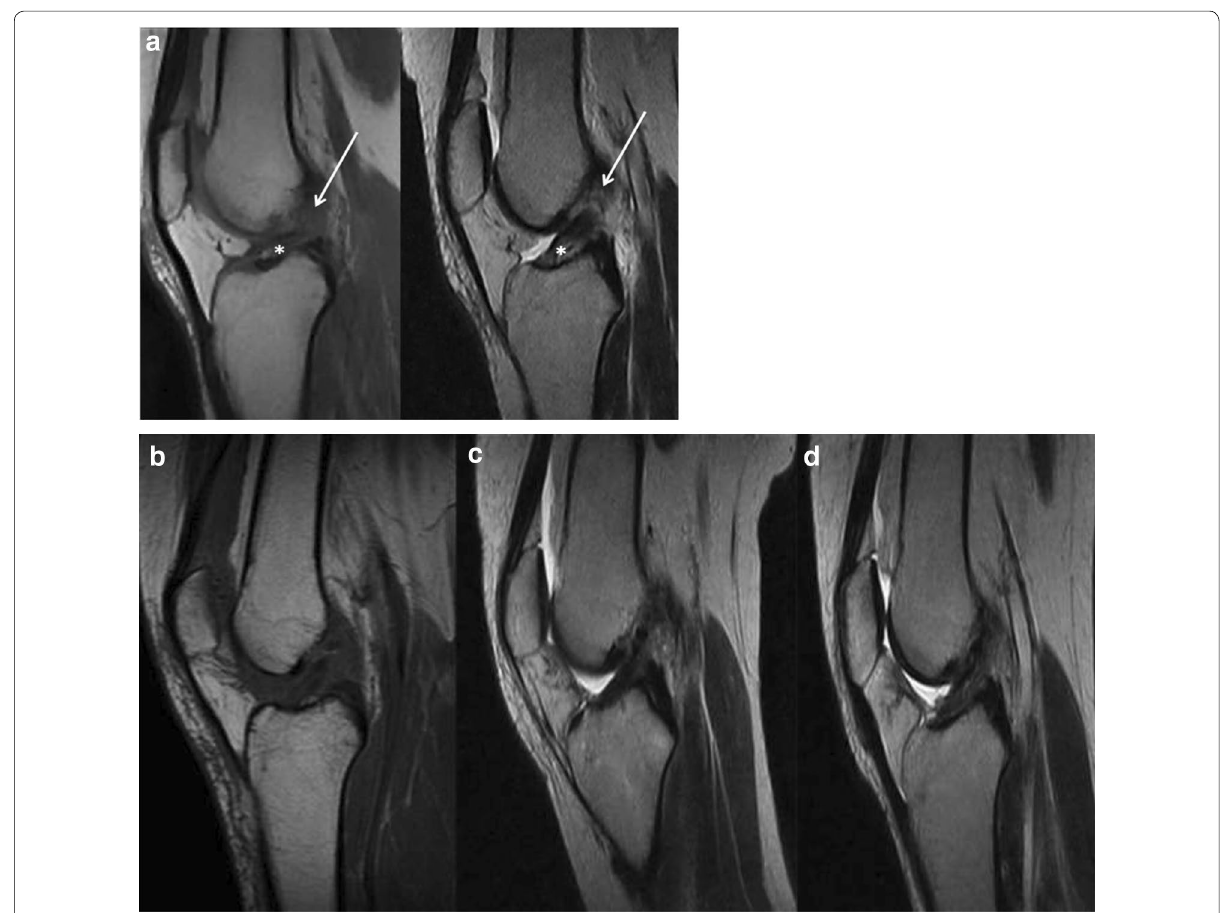
Fig. 4 Pre- and postoperative images of patient #6. a Sagittal preoperative MRI T1-TSE (left) and T2-TSE (right). Tear location (arrow): type II; tissue quality (asterisk): good b Sagittal T2-TSE 1 month post-op. Morphology: grade 1 (normal); signal intensity: grade 1 (isointense) c Sagittal T2-TSE 3 months post-op. Morphology: grade 1 (normal); signal intensity: grade 1 (isointense) d Sagittal T2-TSE 6 months post-op. Morphology: grade 1 (normal); signal intensity: grade 1 (isointense) TSE turbo